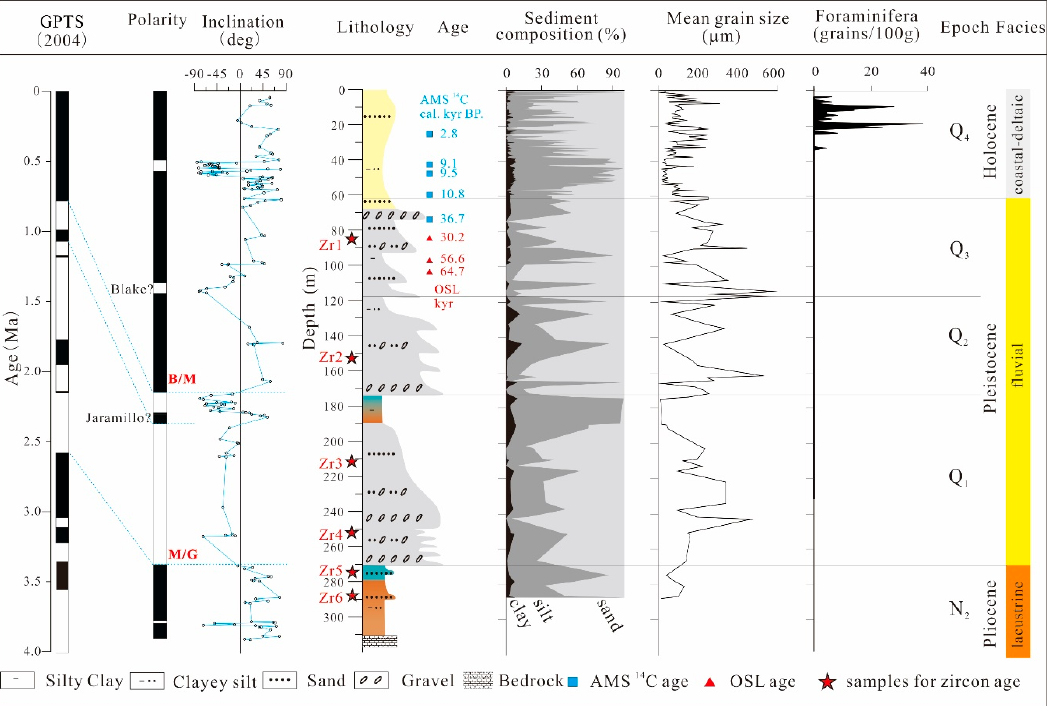
Figure 2. Chronology, lithology and facies of core RGK15. Showing the location of samples for zircon geochronology (Zr1 – Zr6).